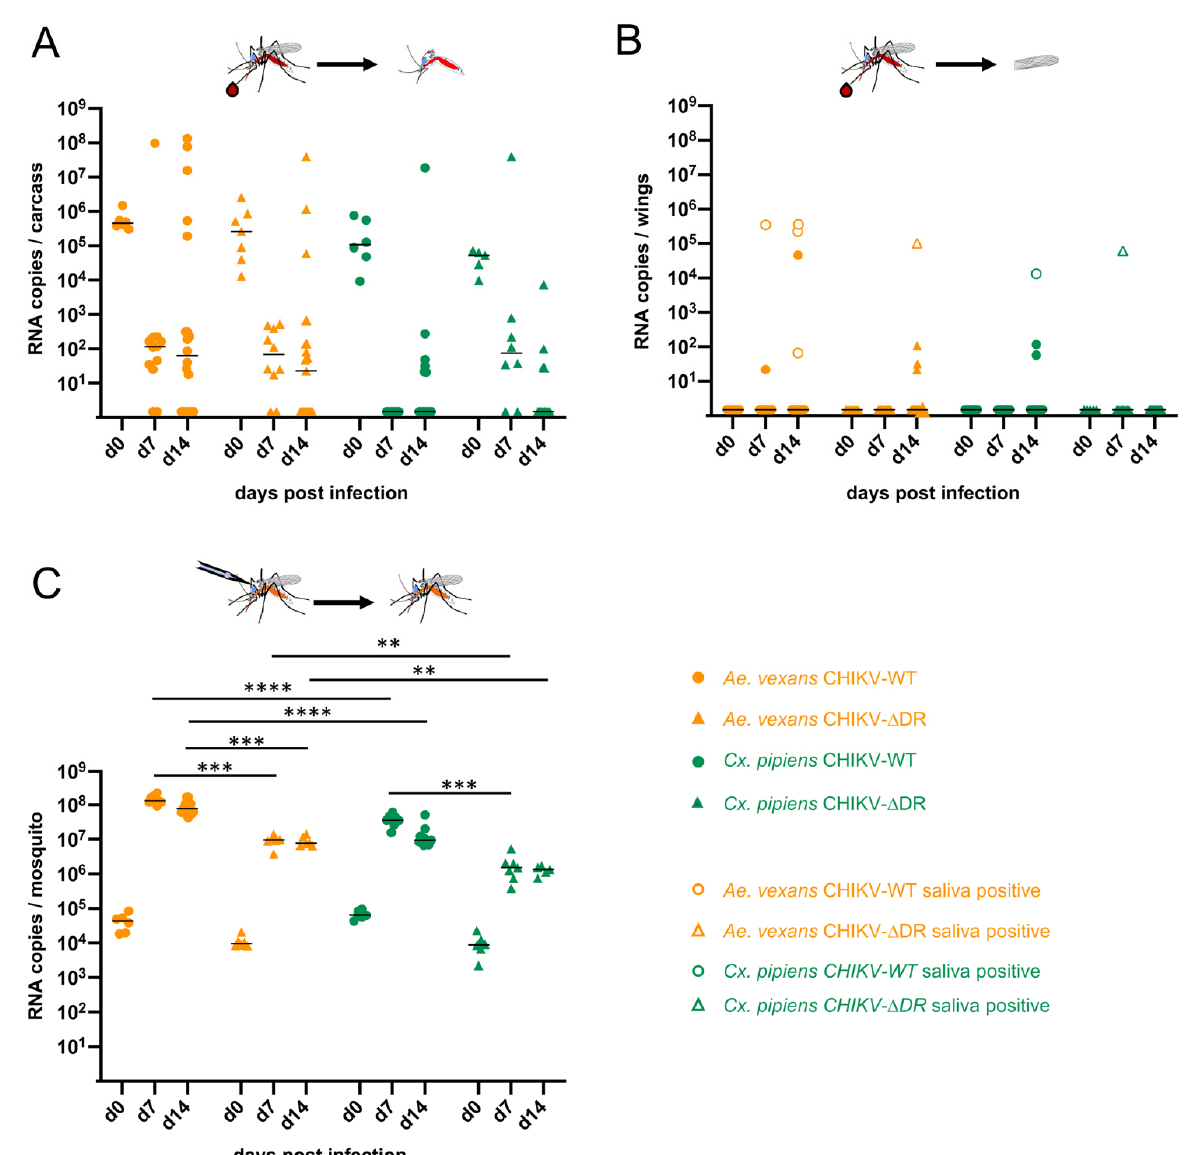
Figure 3. Infection of Ae. vexans and Cx. pipiens with CHIKV-WT and CHIKV- ∆ DR. ( A ) Infection of mosquitoes after oral feeding with blood meal containing 1 × 10 6 PFU/mL CHIKV-WT or CHIKV- ∆ DR. At d0, d7, and d14 post infection, mosquitoes were dissected and viral RNA copies were determined in the carcasses of the mosquitoes by real-time RT-PCR. ( B ) Dissemination of virus into secondary tissues after oral infection. At the indicated time points, viral RNA copies in the wings were determined. Open symbols indicate disseminated mosquitoes for which also transmission into saliva was detected. ( C ) Intrathoracic infection of mosquitoes using 200 PFU of CHIKV-WT or CHIKV- ∆ DR. At the indicated time points viral load in the whole mosquitoes was determined. Each symbol represents a single female mosquito. The black line indicates the median of the viral RNA copies in each group (** p < 0.01; *** p < 0.001; **** p < 0.0001). Female Ae. vexans and Cx. pipiens were orally feed with a blood meal containing 1 × 10 6 PFU/mL CHIKV-WT or CHIKV- ∆ DR, respectively (Figure 3A,B). Analysis of the viral titers in the Ae. vexans carcasses at d7 and d14 post infection revealed infection rates for CHIKV-WT of 83.3% (d7) and 65% (d14), and for CHIKV- ∆ DR of 80% (d7) and 47.8% (d14), respectively (Figure 3A, Table 3). To assess whether infected Ae. vexans are able to disseminate the viruses, wings were analyzed for genomic RNA of CHIKV (Figure 3B). At the early time point of 7 days post infection, the dissemination rate for CHIKV-WT was 20% at d7 and increased to 30.8% at d14. An increase of the dissemination rate over